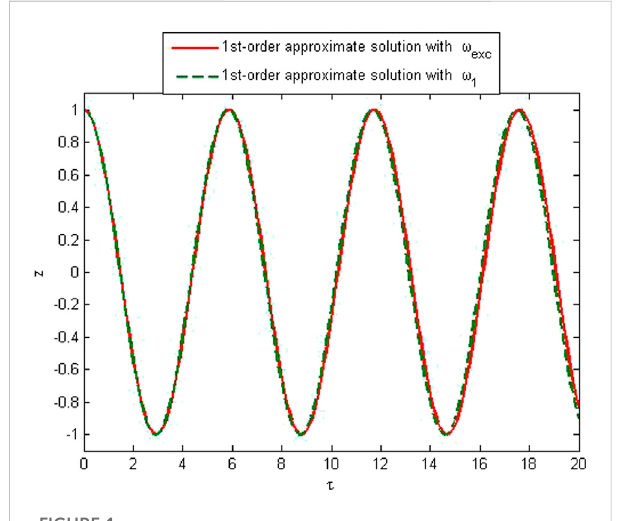
FIGURE 2 Illustration of the fi rst-order approximate solution with A (cid:2) 5.